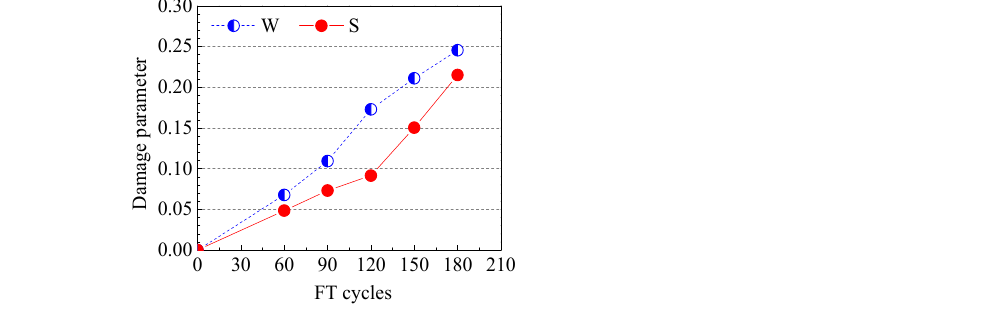
Figure 6. Evolutions of damage parameter of water-exposed (W) and sulfate-exposed (S) RAC samples at different freeze–thaw cycles.